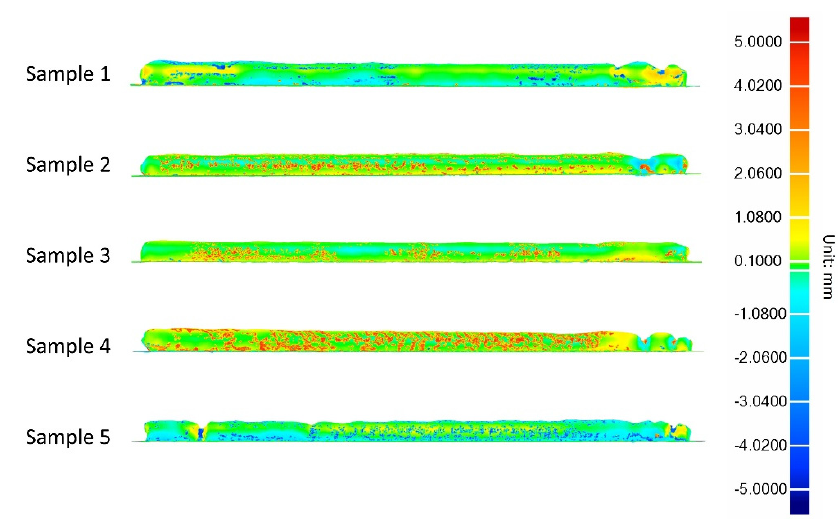
Figure 6. Comparison of each specimen with the ideal model.